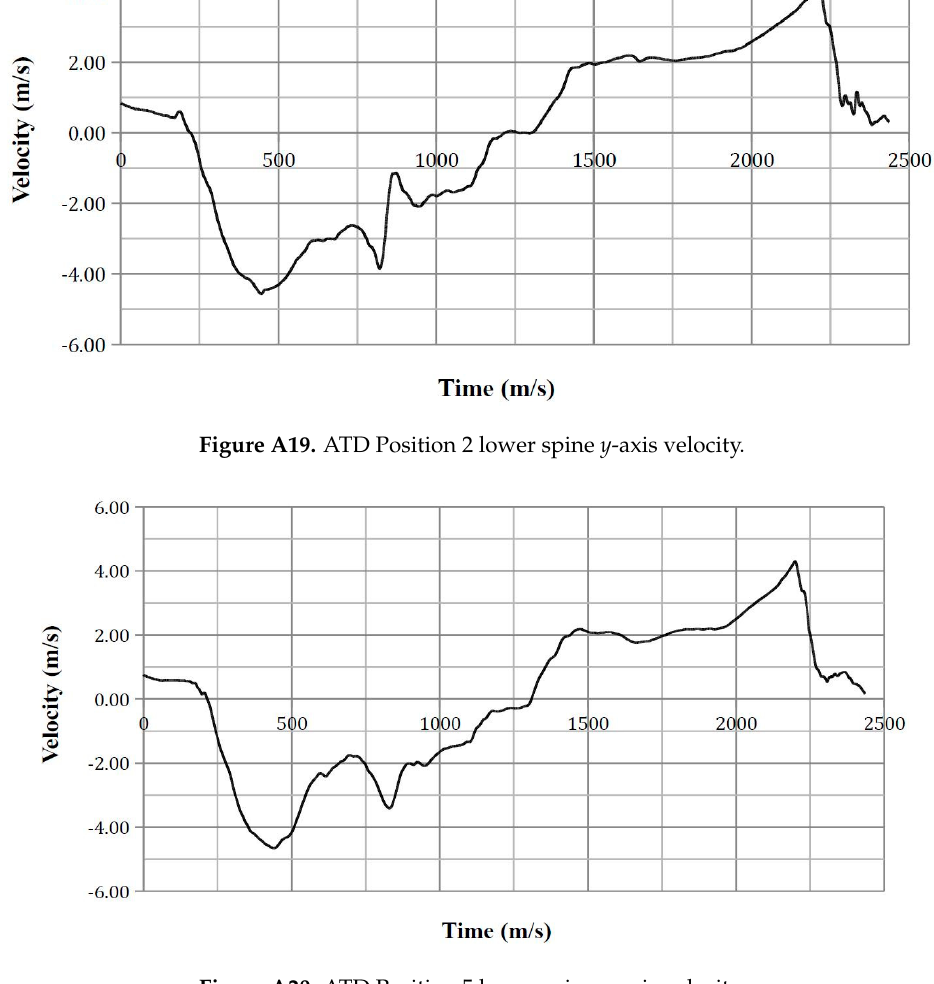
Figure A20. ATD Position 5 lower spine y-axis velocity.